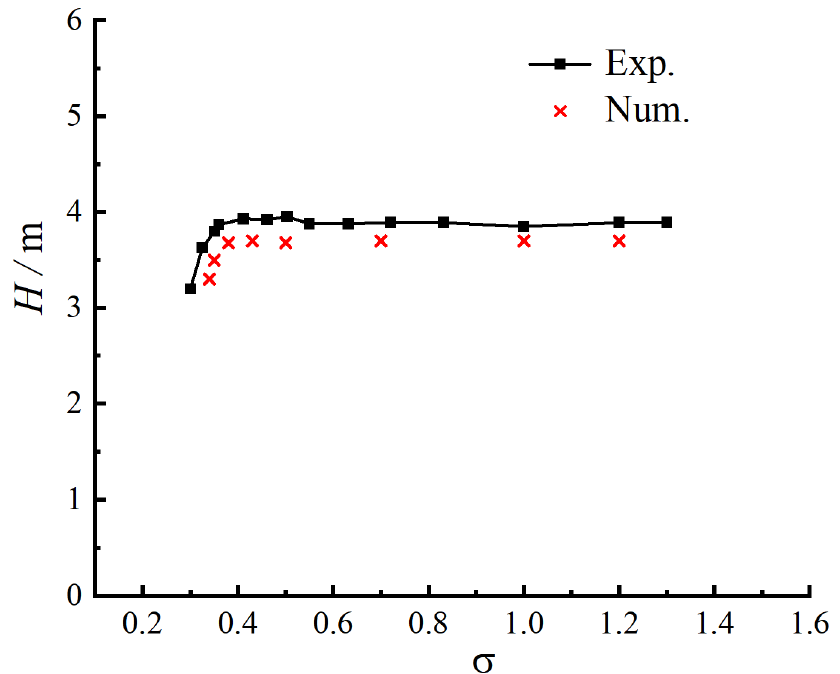
Figure 6. Comparison of the axial flow pump’s σ – H curves from the numerical simulation and experiments ( Q =0.8 Q BEP ).